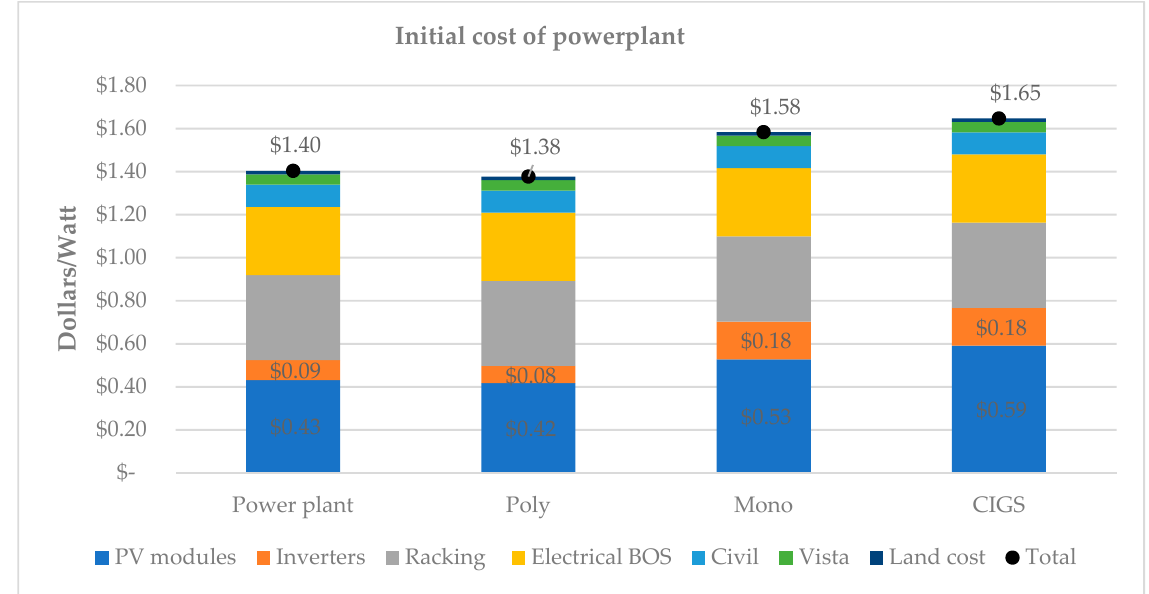
Figure 12. System cost for the power plant.